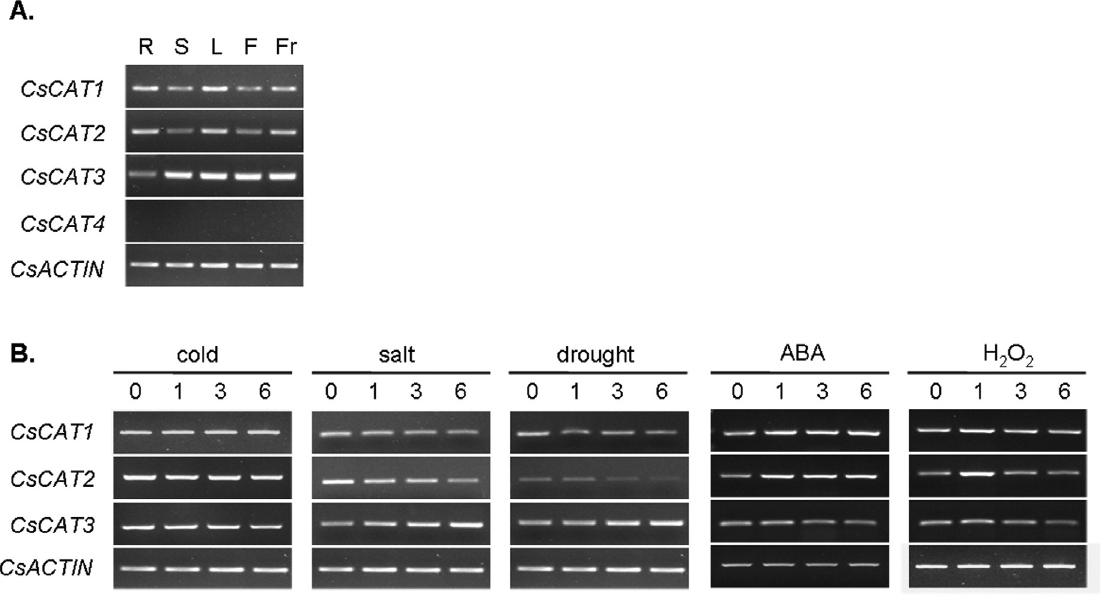
Figure3 -RT-PCRanalysisofcucumber CsCAT genes,(A)indifferenttissuesand,(B)undersalt,cold,drought,H 2 O 2- ,andABAstressconditionsfor0, 1, 3, and 6 h. RT-PCR was performed using primers specific to the CsCAT genes. PCR products were run on 1.5% agarose gels. CsACTIN primers that generated a 161 bp product, which was used as the internal standards for each CsCAT gene. Sources of the samples are as follows: (R) root, (S) stem, (L) leaves, (F) flowers, and (Fr)